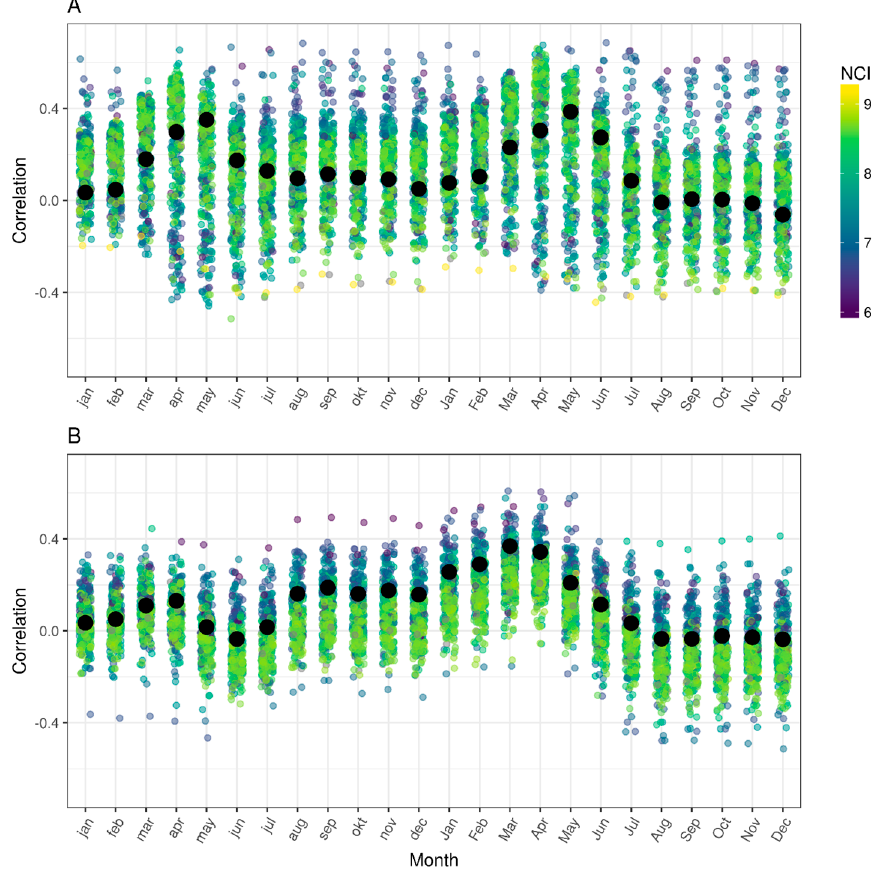
Figure 1. Jitterplot of ( A ) Pearson correlation coefficients of the raw tree-ring width with the SPEI9 for individual trees (small colored points) and for the mean population chronology (big black points). The neighborhood competition index (NCI) was used as color scale for individual trees; ( B ) the same correlations as in (A), but using detrended ring width (tree-ring indices (TRI)) and SPEI9 time-series (30-year cubic smoothing spline and ring width was additionally prewhitened).